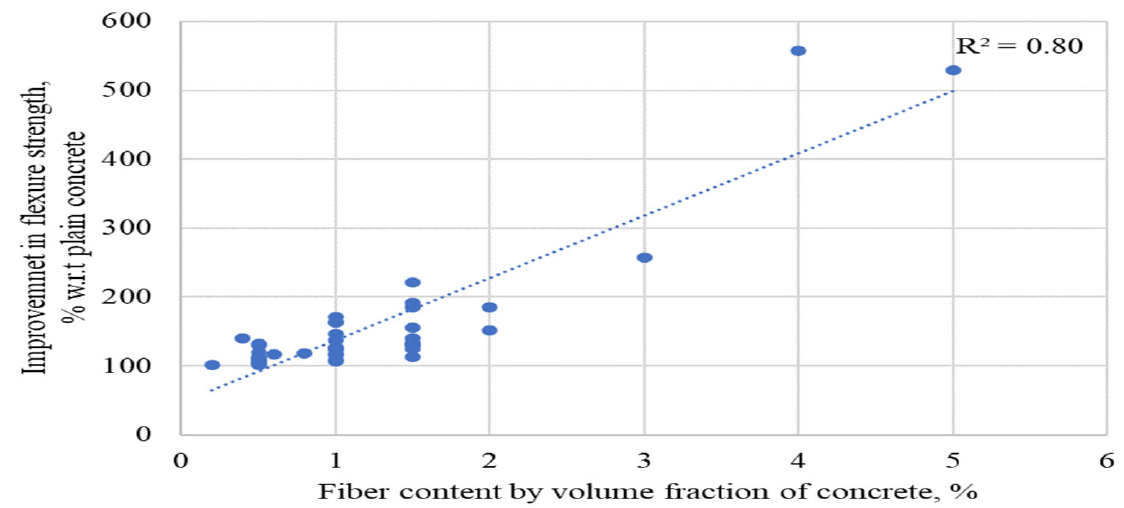
Figure 13. Percent comparison of RSF content with a percent increase in flexure strength of RSF concrete.